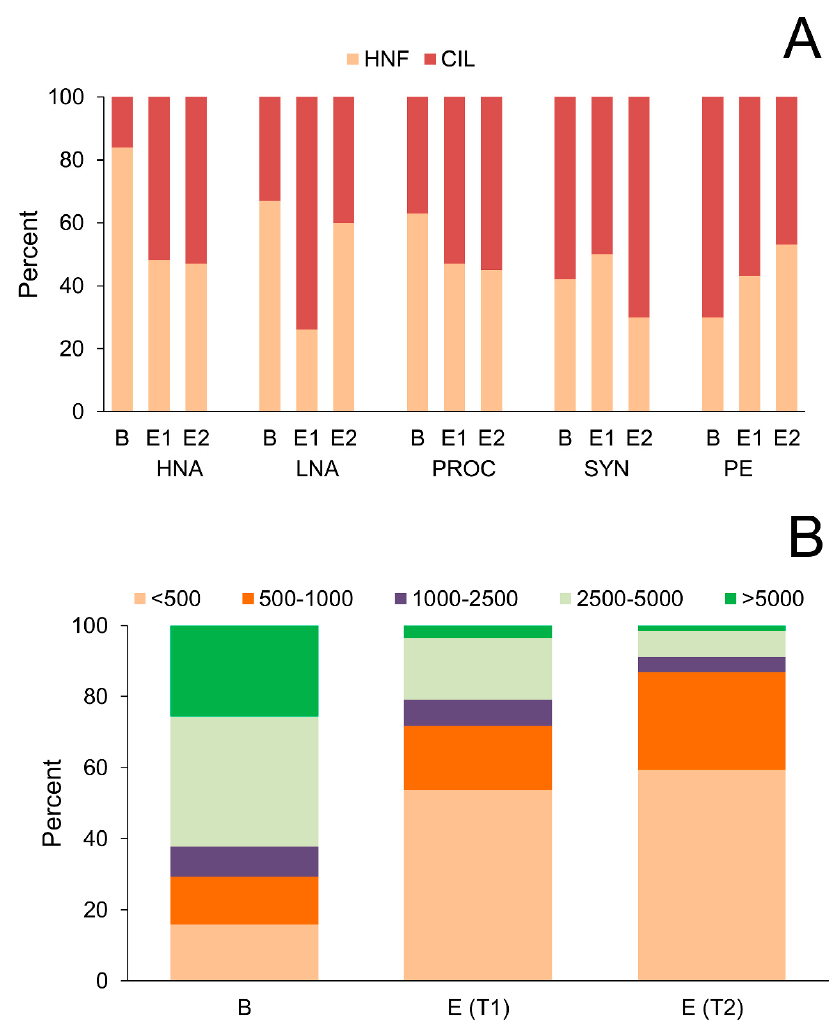
Figure 5. ( A ) Relative contribution of heterotrophic nanoflagellates (HNF) and ciliates (CIL) to total grazing of picoplankton groups at the beginning of the log phase of experiment (B) and at the end of the log phase of the experiment at ambient temperature (E1) and at the elevated temperature (3 °C increase; E2). ( B ) Changes of ciliate cell size categories during the experiment. Ciliate size fractions are expressed as carbon biomass per cell (pgC cell − 1 ). HNA, high nucleic-acid bacteria; LNA, low nucleic-acid bacteria; PROC, Prochlorococcus ; SYN, Synechococcus ; PE, picoeukaryotes.